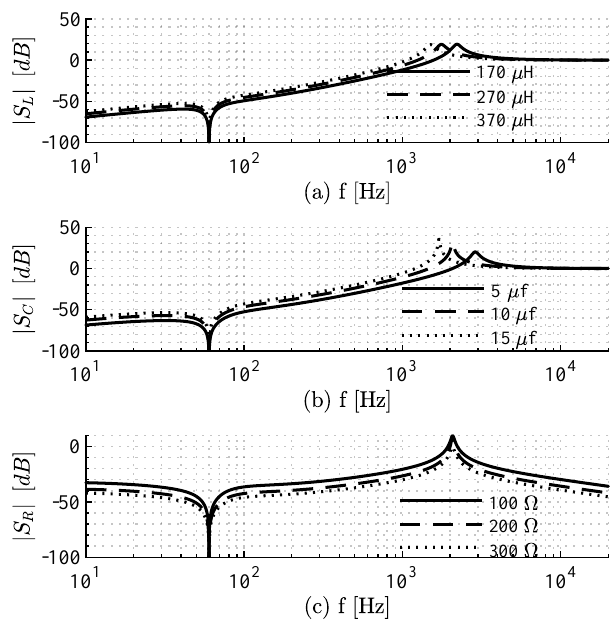
Figure 32. Sensitivity due to: ( a ) L , ( b ) C , and ( c ) R